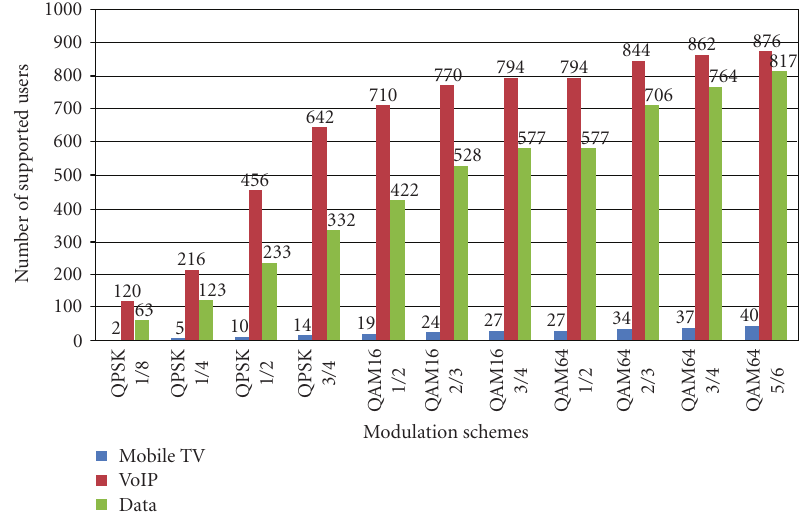
Figure 6: Number of users supported in a lossless channel (Enhanced Scheduler).